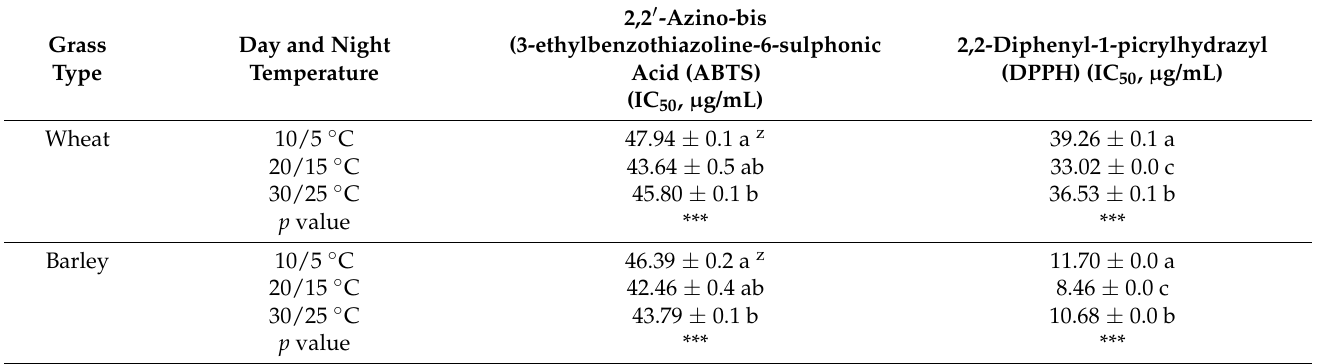
Table 4. Antioxidant activities of young wheat and barley grass extracts treated at different growing conditions.